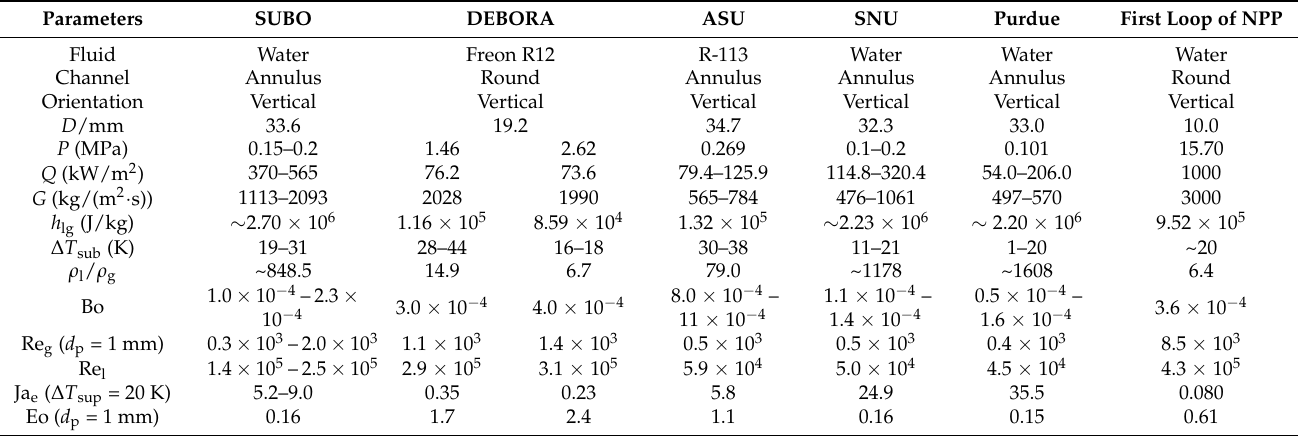
where Re g number and Eo number are calculated with bubble diameter d p = 1 mm; Ja e number is obtained with wall superheat ∆ T sup = 20